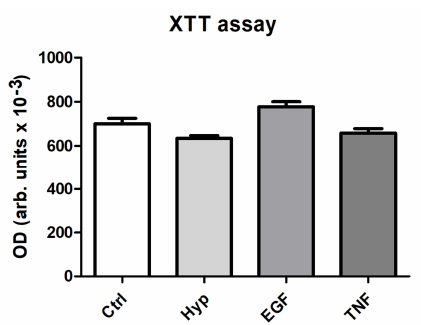
Figure 2. Cell viability after preconditioning for 48 h. Murine ASC were cultured in 96-well plates and preconditioned for 48 h. The XTT assay was performed and optical density (OD) was measured in a microplate reader at 490 nm vs. 650 nm (arbitrary units, mean ± SD, n = 5). No significant effects of the different pretreatments on the cell viability could be detected.